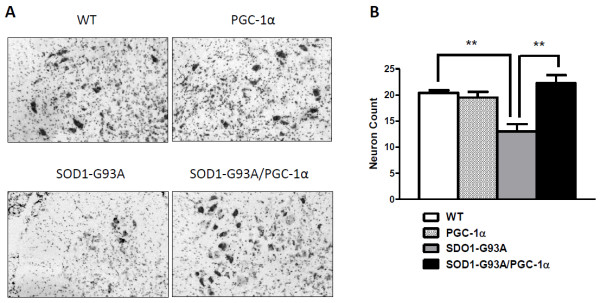
Nissl-stained motor neuron count in the lumbar spinal cord. The effect of the PGC-1α on neuron numbers in SOD1-G93A transgenic mice at post-symptomatic stage (day 110) was examined following Nissl-staining. (A) Photomicrographs of representative Nissl-stained sections through the ventral horns of the lumbar spinal cord from wild-type (WT), SOD1-G93A, PGC-1α and SOD1-G93A/PGC-1α double transgenic mice. (B) Motor neuron counts in lumbar spinal cord (data = Mean ± SE, n = 5, **p < 0.05).